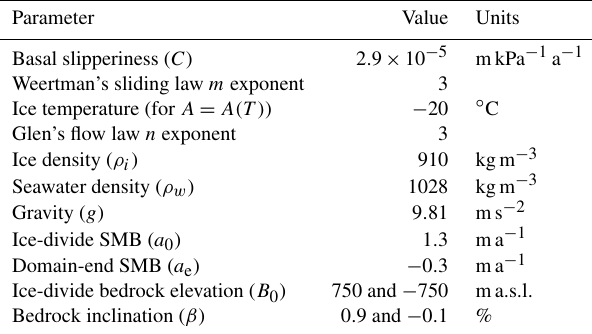
Table 1. Model parameters used in this study. Values for B 0 and β reflect values for prograde and retrograde slopes,